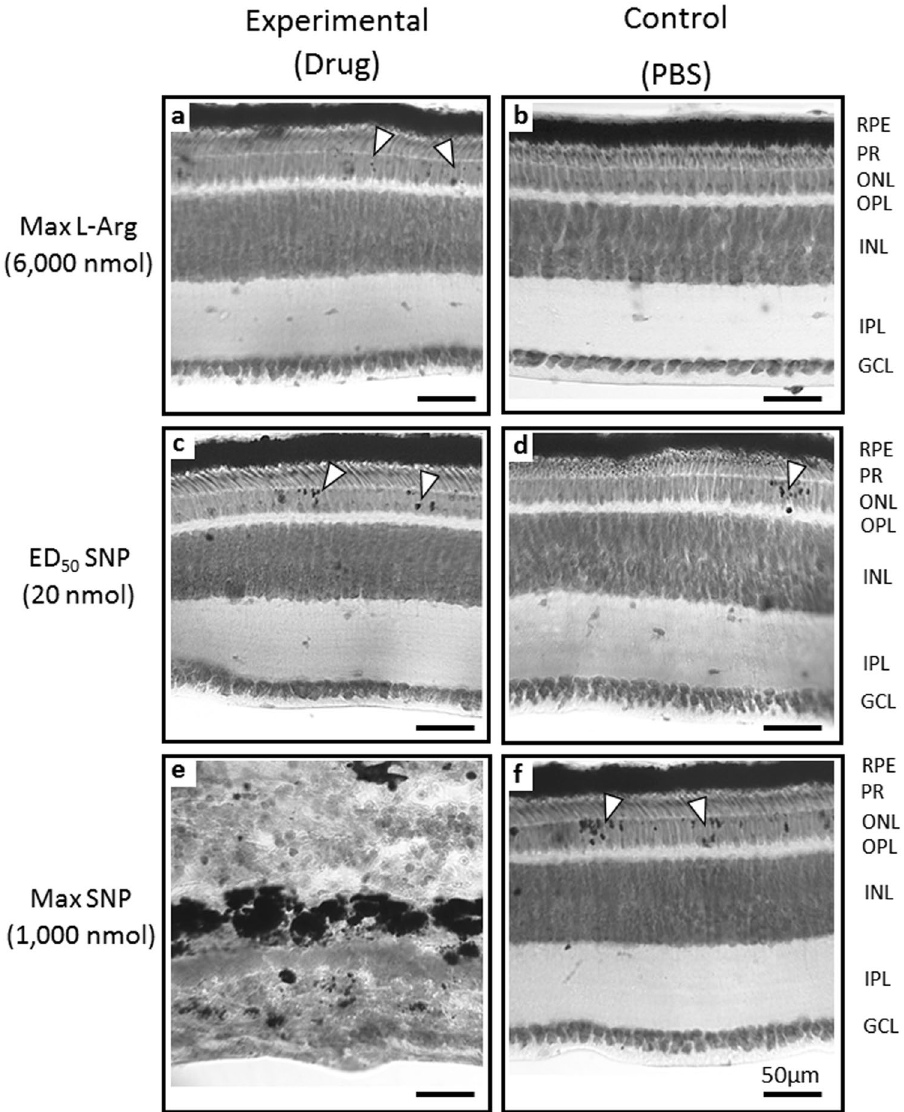
Figure 3. Transmission light micrographs of Toluidine blue-stained retinas treated with L-Arg and SNP, and their contralateral PBS-treated controls. There was no obvious damage to retinal or RPE structure in eyes treated with either the ED 50 (Supplementary Fig. S2) or the maximum dose of L-Arg ( a ), but small pigment deposits were present in the ONL ( ▽ ) that were not seen in the PBS-only control ( b ). At the ED 50 of SNP, there was an increase in the small pigment deposits in the ONL ( ▽ ), in treated ( c ) and control ( d ) tissues; otherwise, the structure of the retina and RPE remained largely unaffected. At the maximum concentration of SNP, there was massive degeneration of the retina and RPE, with complete loss of the photoreceptor and ONL/OPL; INL and GCL were still detectable, but distorted ( e ). Contralateral control eyes ( f ) had a significant increase in pigment in the ONL; but the structure of the retina and RPE remained intact. Abbreviations: RPE [retinal pigment epithelium]; PR [photoreceptor inner and outer segments (bacillary layer)]; ONL [outer nuclear layer]; OPL [outer plexiform layer]; INL [inner nuclear layer]; IPL [inner plexiform layer]; GCL [ganglion cell layer]. Widefield (25x, NA 0.8). Scale bar = 50 µ